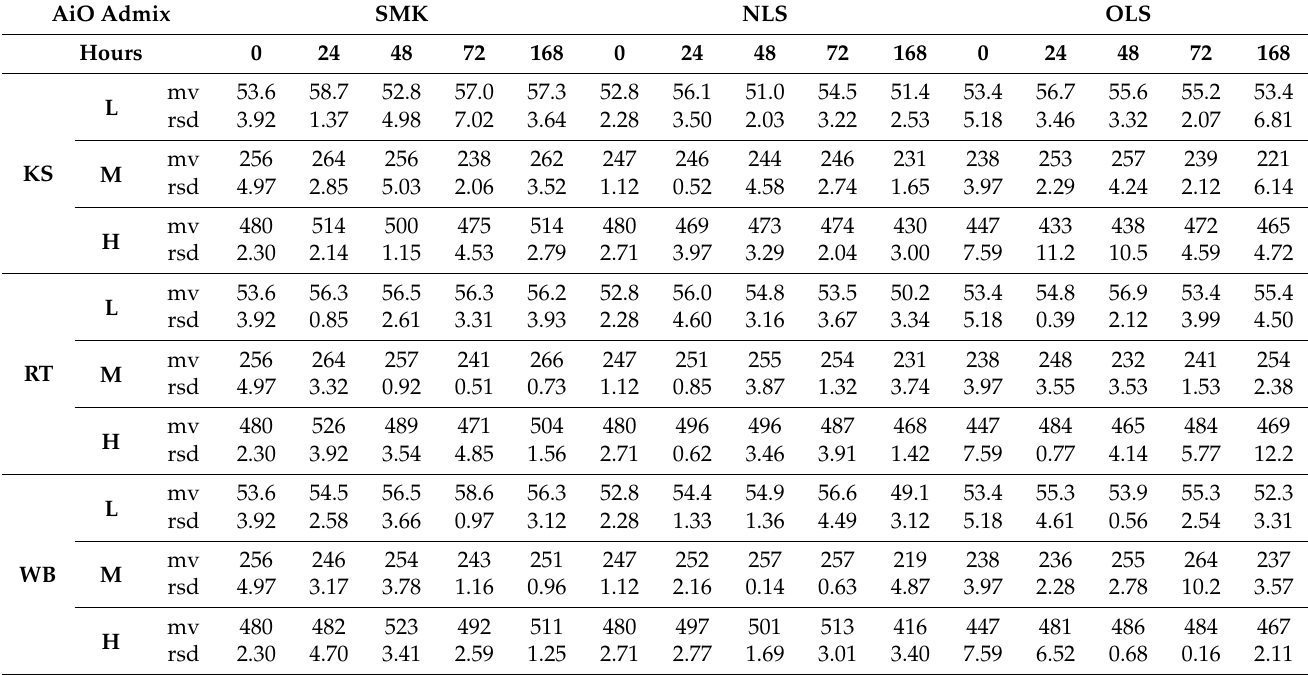
Table 3. Voriconazole concentrations over one week (168 h) in different AiO PN admixtures, results of the LC–MS/MS analysis. AiO Admix SMK NLS